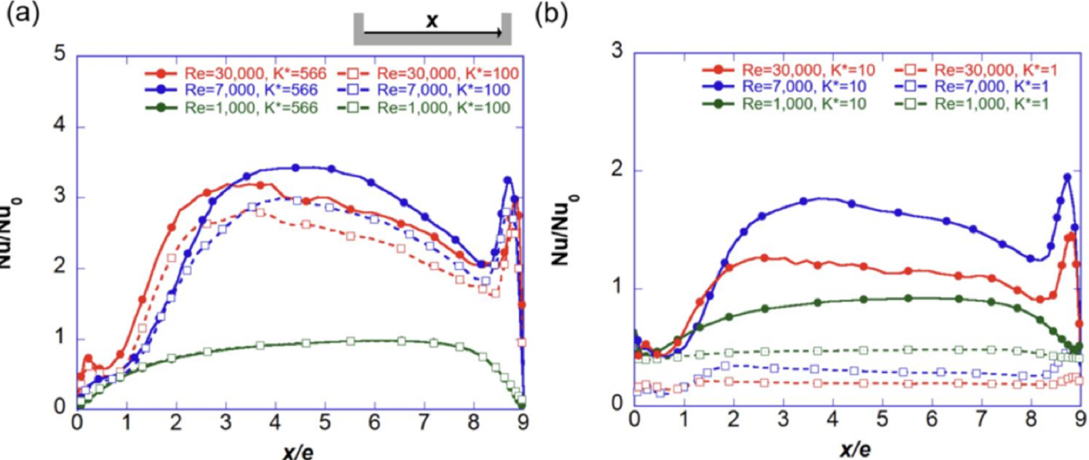
Figure 6. Effect of the Reynolds number on the local Nusselt number along the channel wall between the ribs: ( a ) for high thermal conductivity ratios ( K * = 566.26 and 100.00) and ( b ) for low thermal conductivity ratios ( K * = 10.00 and 1.00).